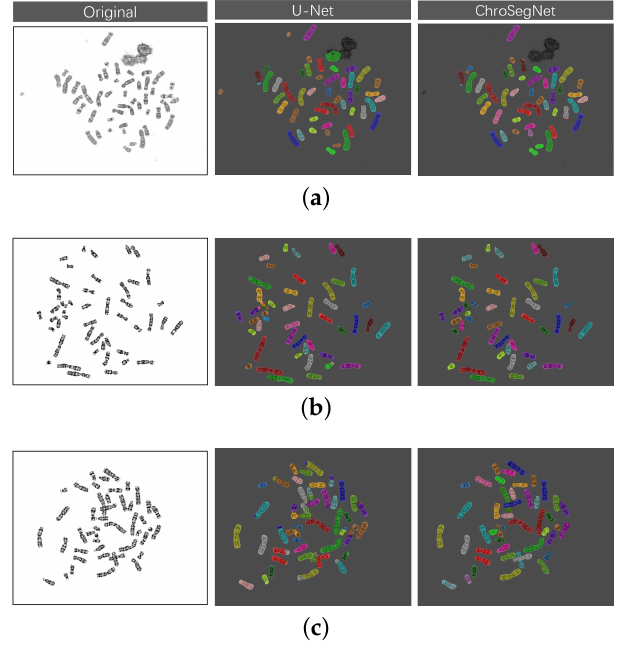
Figure 7. Comparison of segmentation masks between ChroSegNet and U-Net on chromosome microscopy images. From left to right are the original image, the U-Net segmentation mask, and the ChroSegNet segmentation mask. ( a ) Group A comparison; ( b ) Group B comparison; ( c ) Group C